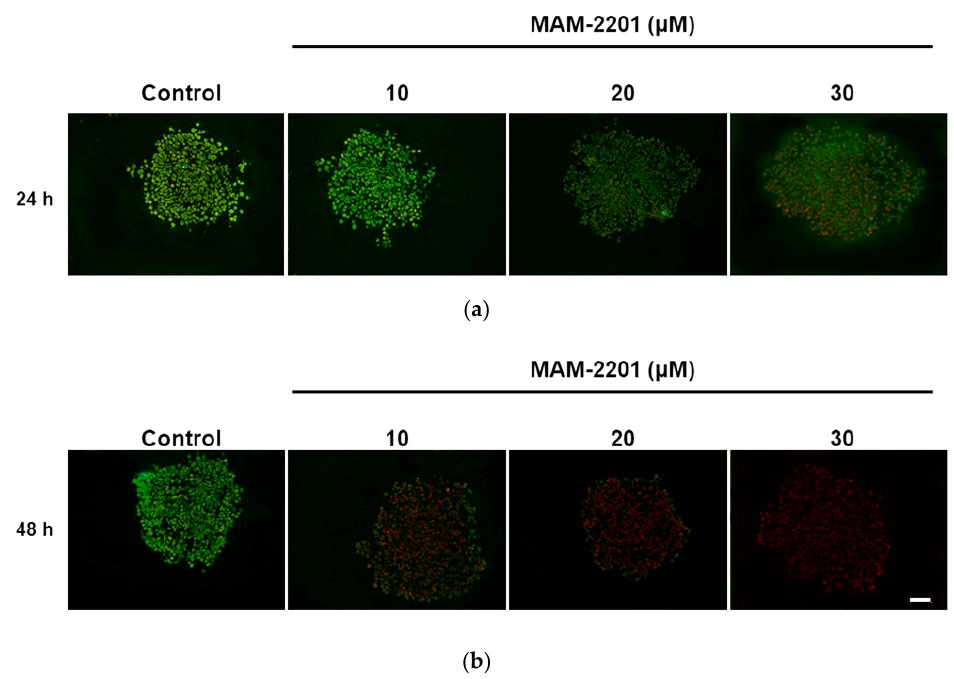
Figure 11. Immunofluorescence analysis of GFAP in astrocyte spheroid sections after ( a ) 24 and ( b ) 48 h of exposure to MAM-2201 (10, 20, and 30 µ M). A loss of the GFAP fluorescence signal (green) was observed in D384 spheroids, starting at 20 µ M after 24 h, and was exacerbated and worsened (starting at 10 µ M) after 48 h of exposure. Nuclei were stained with propidium iodide. Scale bar: 100 µ